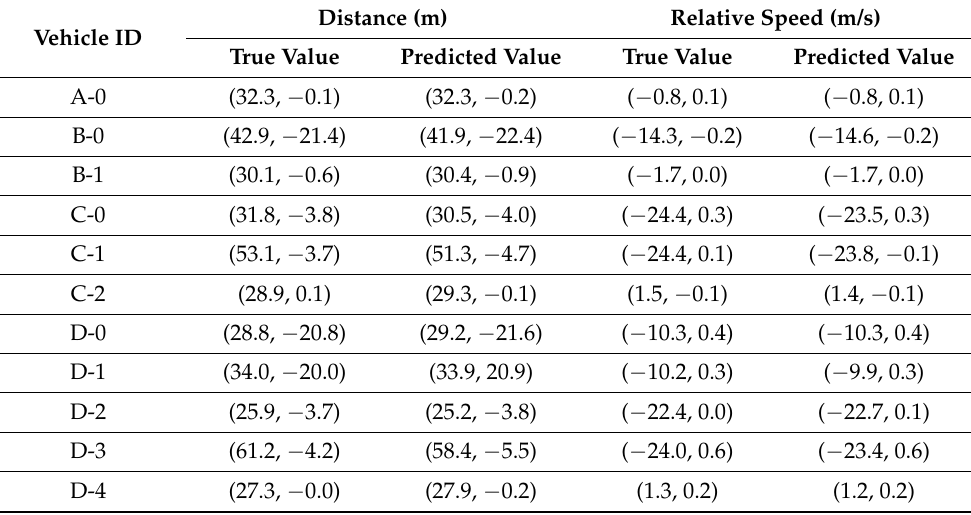
Table 8. Qualitative results obtained from predictions corresponding to Figure 5.